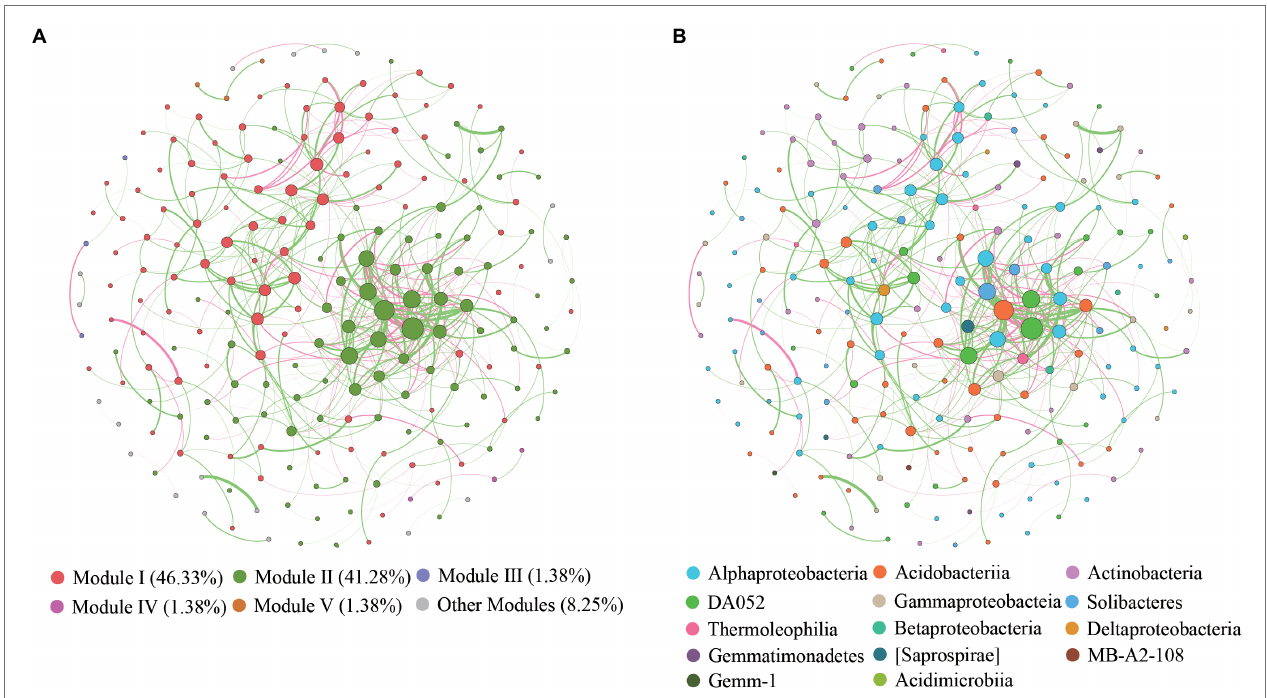
FIGURE 6 | Co-occurrence patterns of OTUs in bacterial communities. Nodes are colored according to different (A) modularity classes and (B) class-level taxonomy.